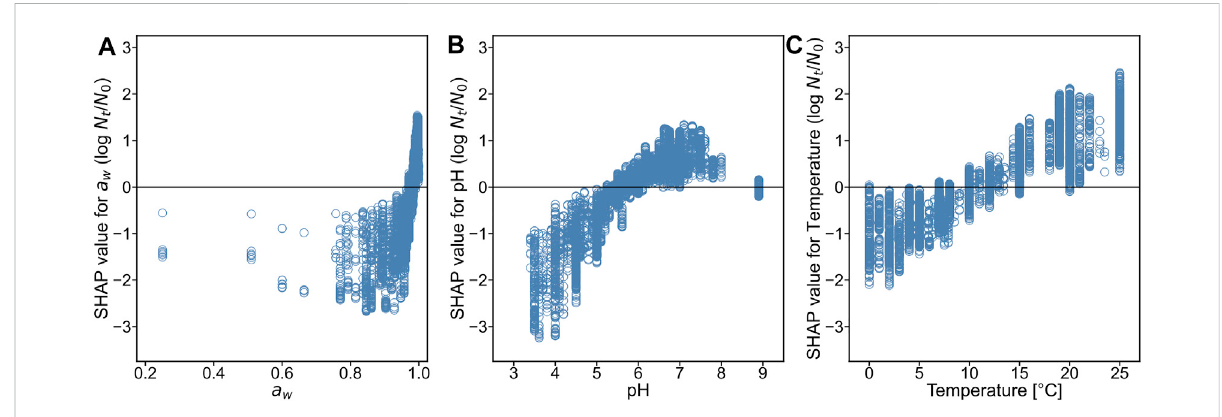
FIGURE 7 SHapley Additive eXplanations (SHAP) dependency plots for water activity (A) , pH (B) , and temperature (C)